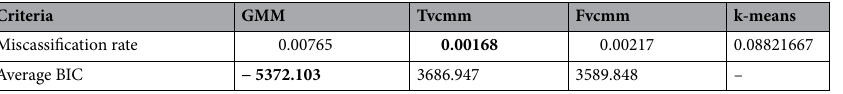
Table 2. The summary of the performance of the Tvcmm and Fvcmm, GMM, and k-means methods fitted to the simulated data with 300 observations. Tvcmm, Fvcmm, GMM, and k-means refer to the truncated vine